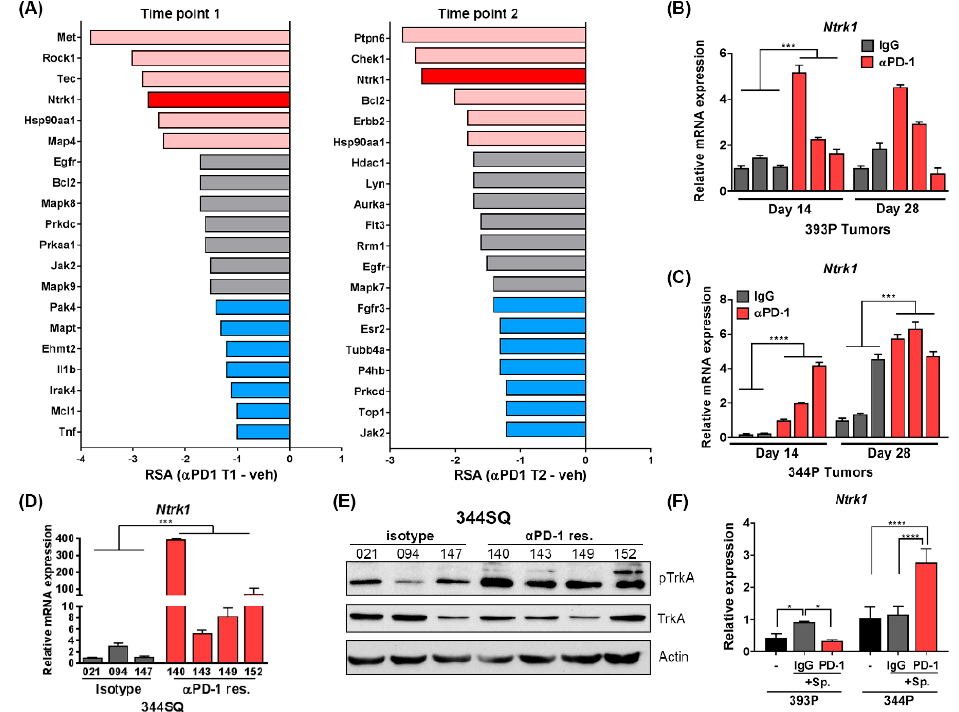
Figure 2. Ntrk1 shRNA drops out significantly from 344P tumors treated with anti-PD-1 and is upregulated in tumor cells treated with anti-PD-1 antibody. ( A ) Results from FDAome shRNA dropout screen in 344P tumors graphed as a differential score. The RSA from the isotype treatment condition for each gene was subtracted from the RSA from the same gene in the anti-PD-1 treatment group. Time point 1 is shown to the left, and time point 2 to the right. The top 10% of hits are depicted and these are divided into three groups, with the most significant shown in red. Ntrk1 is highlighted in bold red in both graphs. ( B ) Real-time PCR (qPCR) data for Ntrk1 expression in 393P tumors treated with anti-PD-1 or isotype control for 14 or 28 days. Expression values are normalized against L32 reference gene, relative to one isotype treated tumor sample. ( C ) Ntrk1 expression was analyzed in 344P tumors as described in panel B. ( D ) 344SQ tumor cells implanted in syngeneic mice were treated with isotype control or anti-PD-1 antibody. Tumors were collected after development of resistance to PD-1 blockade (~week 6), cell lines were derived from the tumors, and Ntrk1 expression analyzed via qPCR. The numbers below bars denote the individual mouse from which the cell line was derived. ( E ) Cell lines described in panel D were probed for phospho-TrkAY674/675 levels by Western blotting. ( F ) 393P and 344P cells were cultured in vitro either alone (-) or in the presence of splenocytes (sp.) at a 5:1 ratio of splenocytes to tumor cells. The treatment of either IgG or PD-1 blocking antibody was added to the co-culture and after 4 days, splenocytes were washed out and tumor cells were collected for RNA. Ntrk1 expression was analyzed using qPCR.